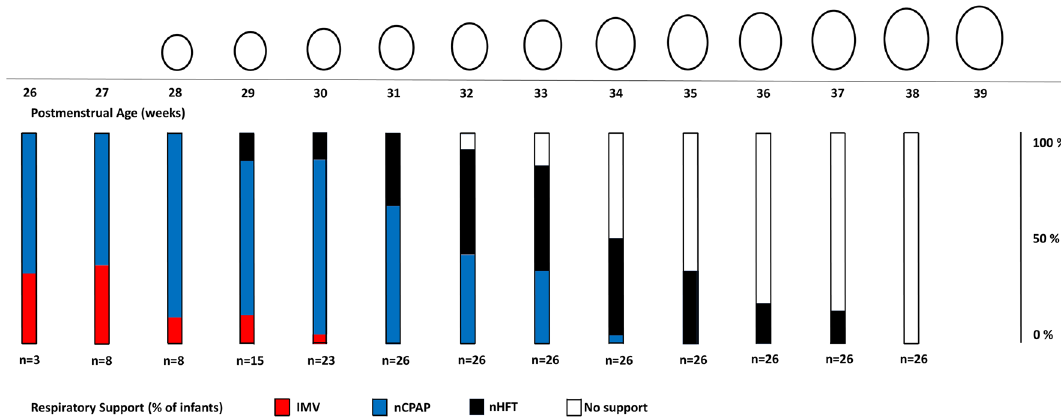
Figure 5. Top: Schematic longitudinal ‘physiological’ head development with mean cranial volume and mean cranial index drawn to scale. Bottom: Total respiratory support subdivided by the different respiratory support modes in relation to postmenstrual age. IMV invasive mechanical ventilation; nCPAP nasal continuous positive pressure, nHFT nasal high-flow